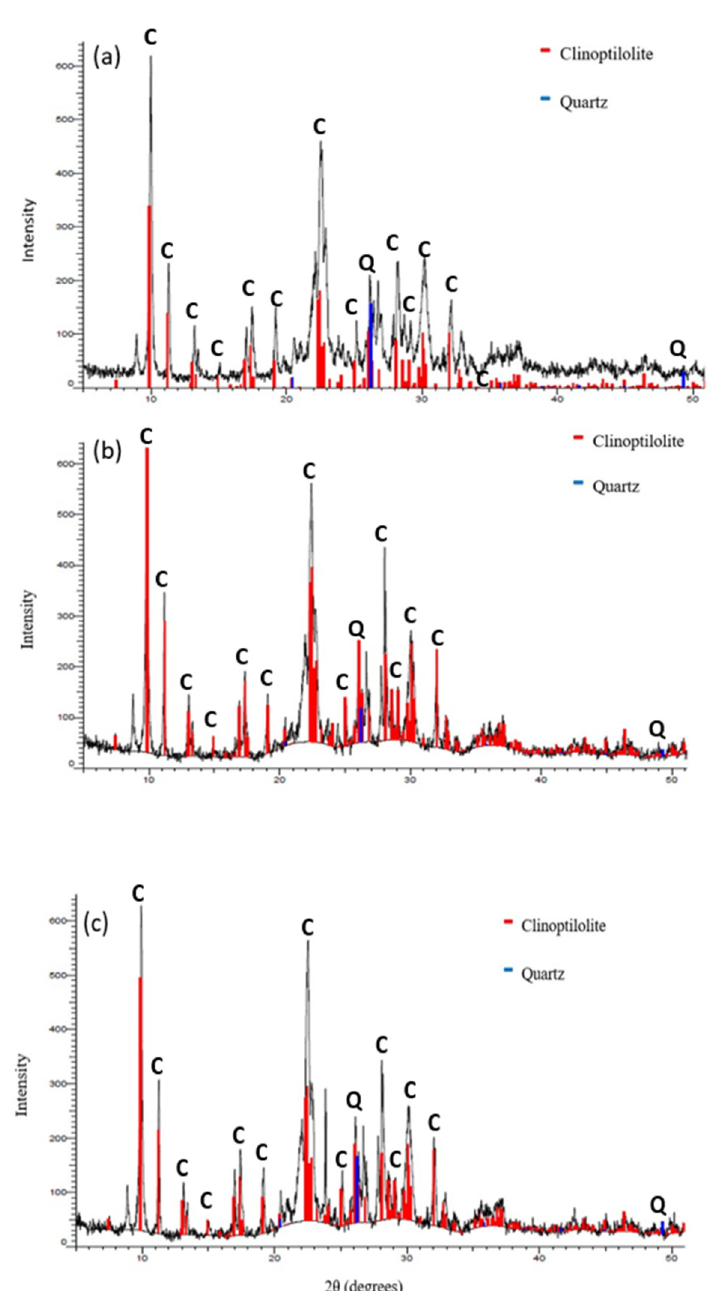
Figure 3. The X-ray diffraction (XRD) patterns of ( a ) NZ, ( b ) PZ, and ( c )